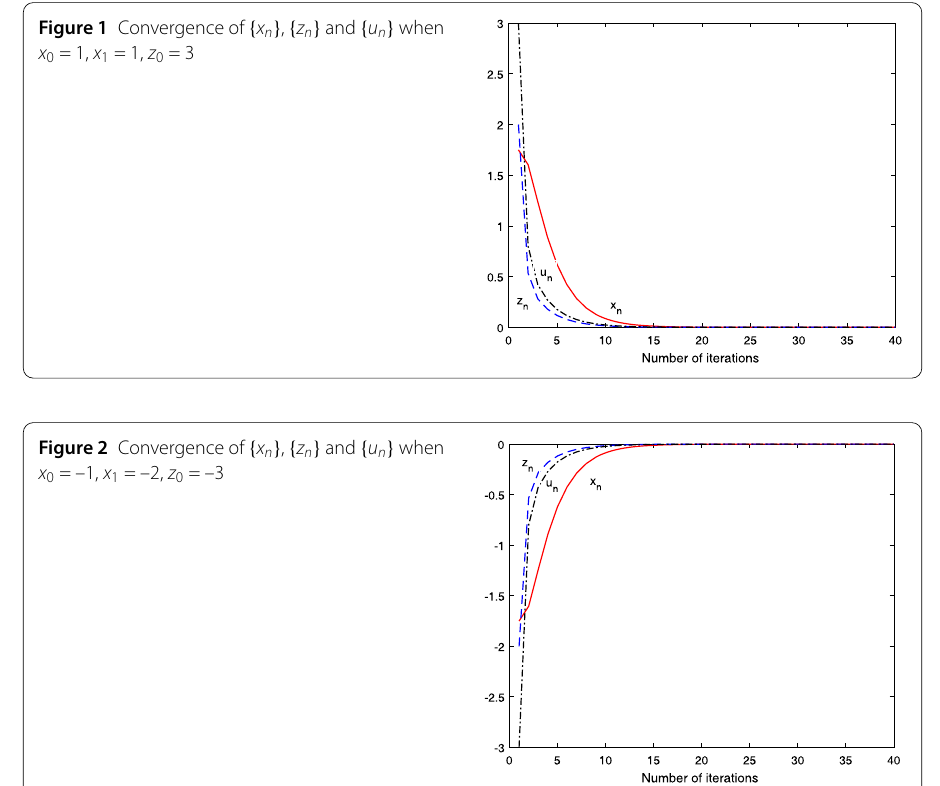
Figure 1 Convergence of { x n } , { z n } and { u n } when